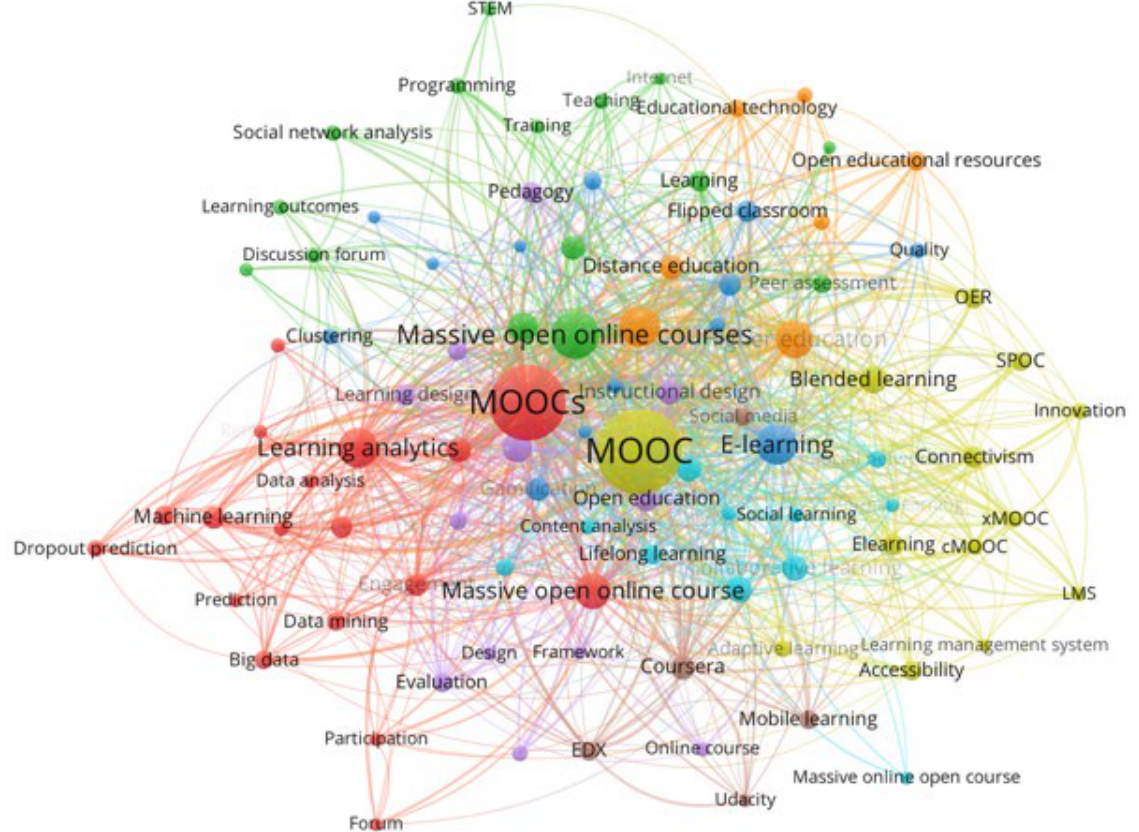
Figure 1 . Network visualization map of author keywords with at least 10 occurrences. Table 7 summarizes the most frequently used keywords in MOOCs studies. After excluding the core keywords related to the search query, the data further revealed that e-learning was the keyword most associated with MOOCs ( n = 1,031). The keyword “massive open online course” was always used either in full or as an abbreviation (MOOC) and was also presented interchangeably either as a singular term or plural. Other keywords that appeared more than 500 times in documents related to MOOCs were education, teaching, and students. This indicated that MOOCs research was mostly concerned with teaching and learning. Other common keywords appearing more than 100 times were (a) curricula; (b)